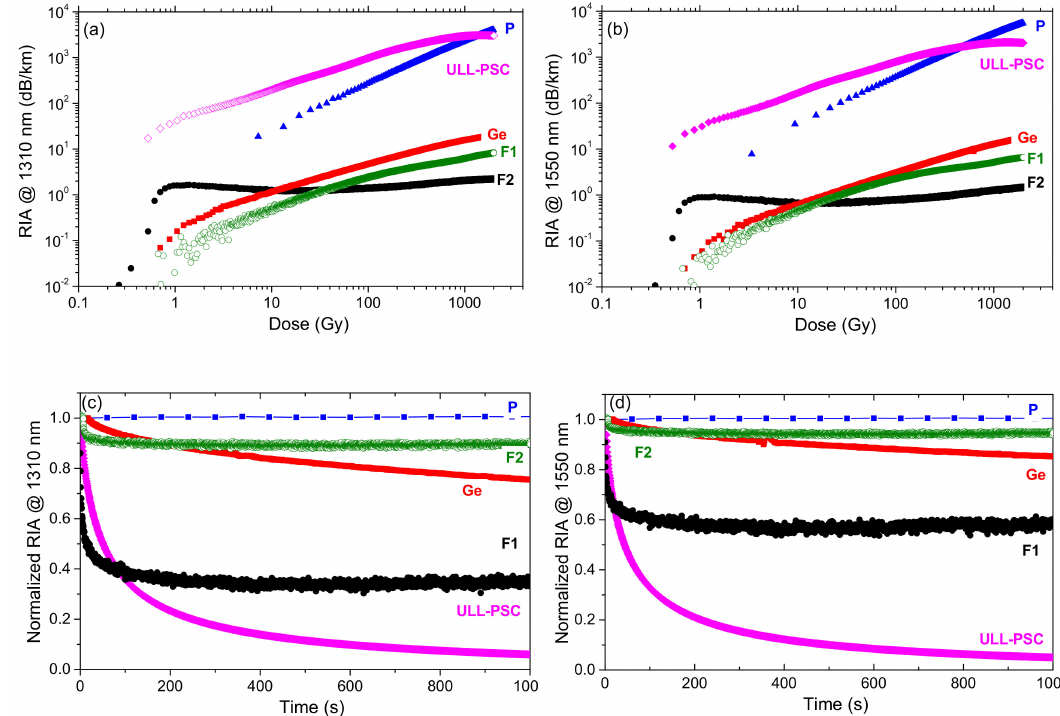
Figure 4. RIA growth kinetics at ( a ) 1310 nm and ( b ) 1550 nm as a function of the dose during the steady state X-ray irradiation (175 mGy / s, room temperature) of the four tested samples: P-doped (blue full triangles), Ge-doped (red full squares), F-doped (green empty circles—F1, black full circles—F2), and ULL-PSC (pink empty diamonds) optical fibers. In ( c ) and ( d ) are illustrated the RIA recovery kinetics after the end of the irradiation for the di ff erent fibers at 1310 nm and 1550 nm,